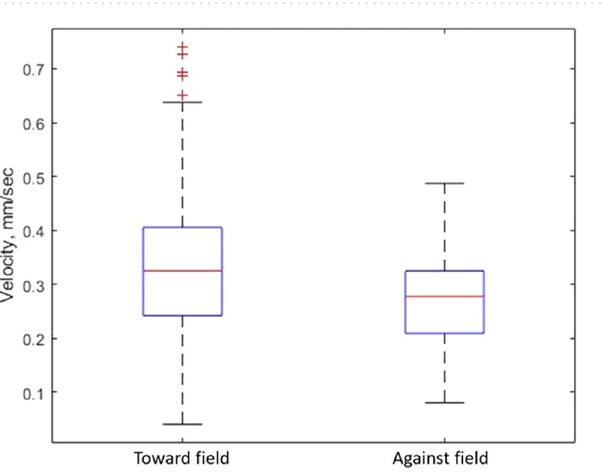
Figure 6. Boxplots showing propagation speeds of chemical waves. Speeds were compared travelling along and against the electric field direction. The median is shown with the red line, and the upper and lower quartiles are shown with the blue box. The black lines show the min and max values, and the red crosses show